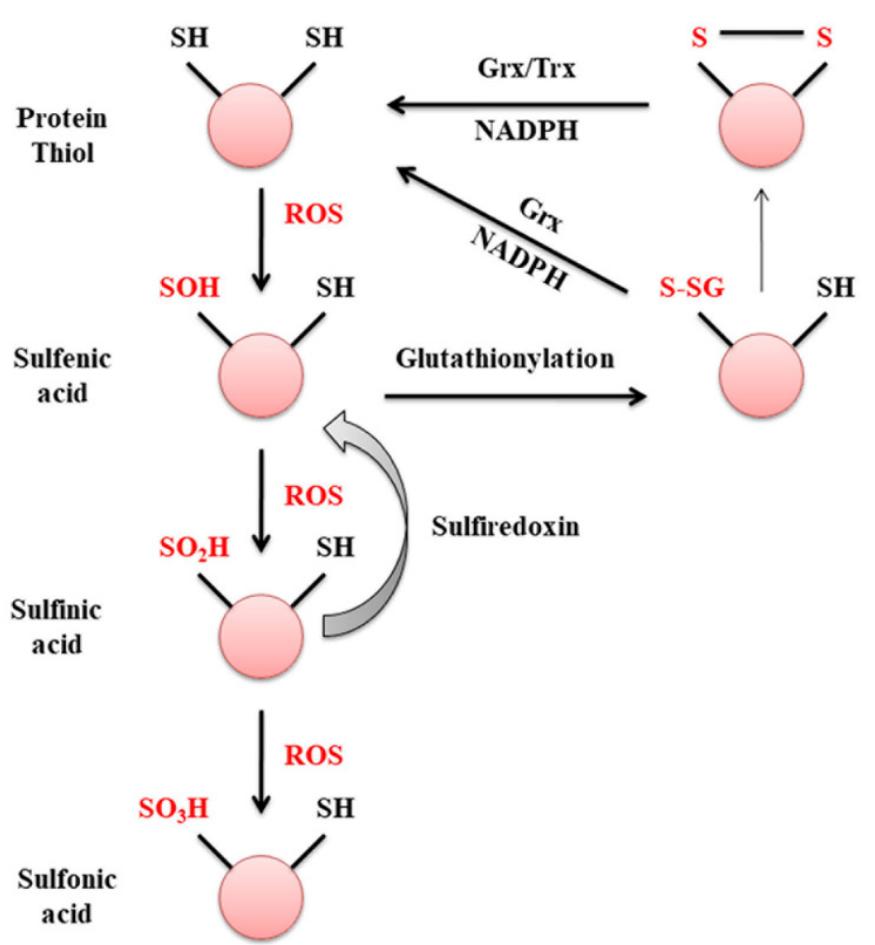
Figure 3. Oxidation of protein thiols to sulfonic acids. During oxidative stress, ROS such as hydrogen peroxide can catalyze the two-electron oxidation of sulfur present in amino acid cysteine. Protein thiols are oxidized to sulfenic acid, which can react with GSH to form protein disulfide preventing further oxidation. Pr-SSG formed is reduced back to active thiols by glutaredoxin or thioredoxin using reducing equivalent NADPH. Sulfinic acid formed by subsequent oxidation of sulfenic acid is still reversible by the reductase enzyme, sulferedoxin. Further oxidation of sulfinic acid results in an irreversible formof sulfonic acid, which targets the protein for